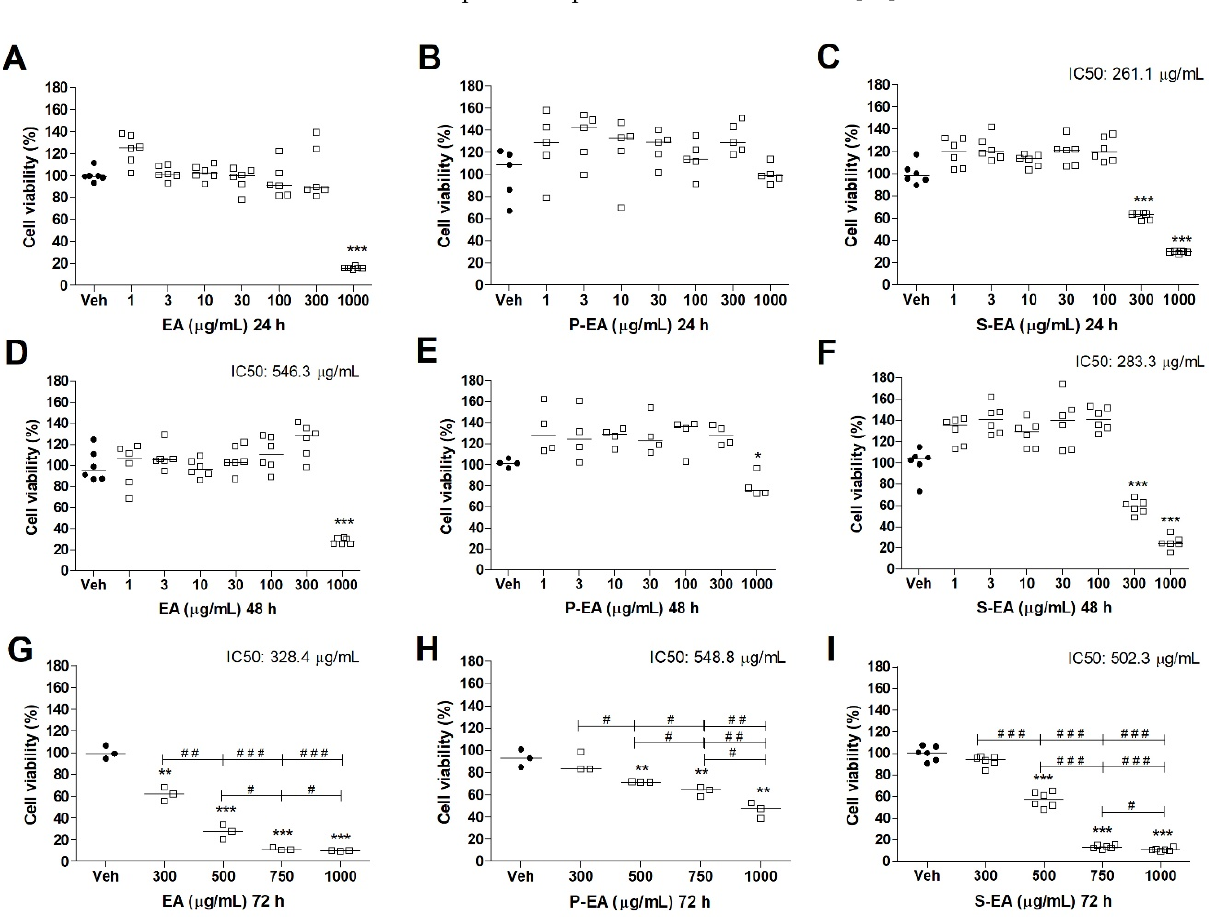
Figure 6. Cell viability determined by MTT assay of MCF7 cell line treated with EA (A, D, G), P-EA (B, E, H), and S-EA (C, F, I). Cells were incubated with the extracts (1, 3, 10, 30, 100, 300, or 1000 µg/mL) for 24 h and 48 h, and 300, 500, 750, or 1000 µg/mL for 72 h. Statistical analyses were performed by unpaired t -test. The results represent the median of three independent experiments ( n = 3–6). * p < 0.05; ** p < 0.01; *** p < 0.001 compared to vehicle group (control group). # p < 0.05; ## p < 0.01; ### p < 0.001 comparison with indicated pairs.